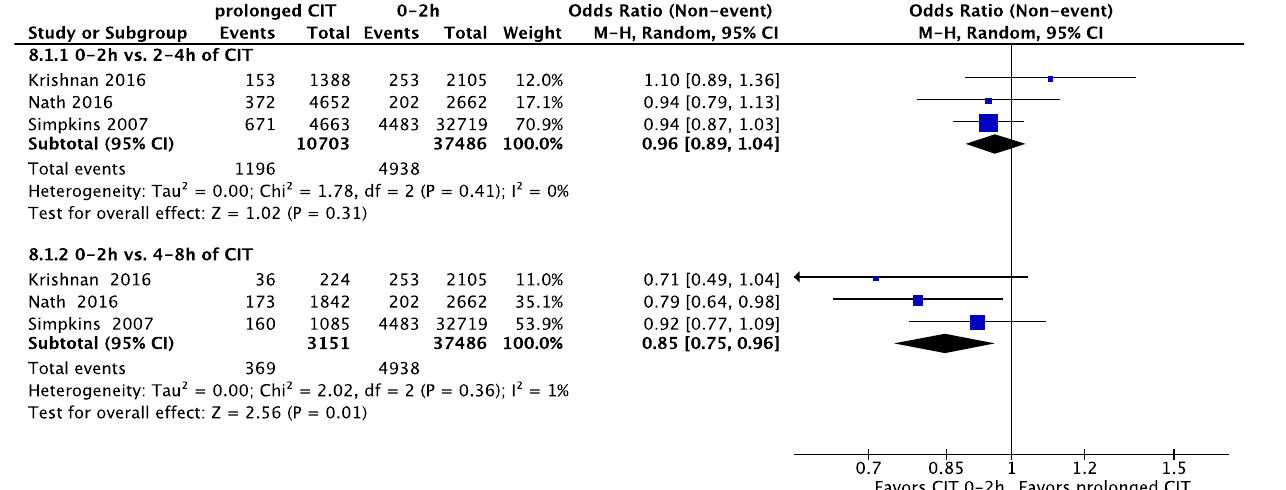
Figure 8. Five-year graft survival; CIT of 0–2 h (reference) versus 2–4 h and 4–8 h of CIT. CIT: cold ischaemia time.